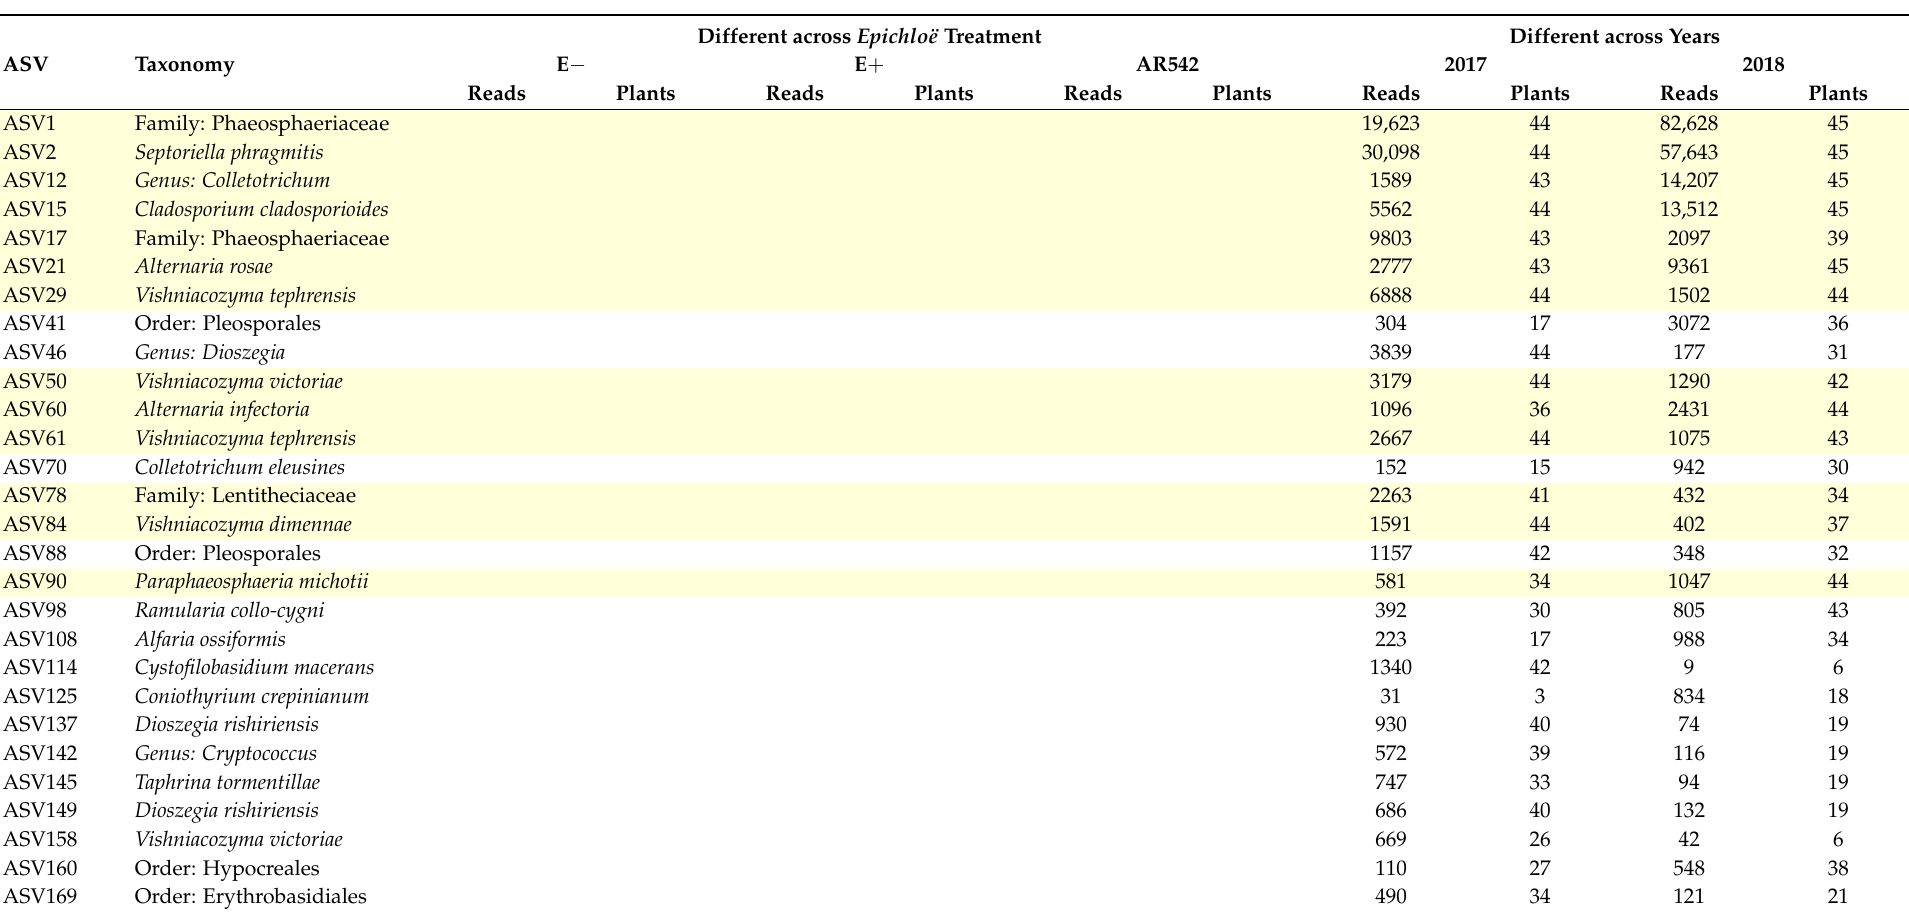
Table 5. Differentially abundant ASVs and the number of reads (summed across all infected plants) and the number of infected plants in which each ASV is present (by Epichloë treatment and Year). Highlighted ASVs are members of the draft core microbiome, see Table 4. Note that taxonomic assignments at the species level are only tentative; see Section